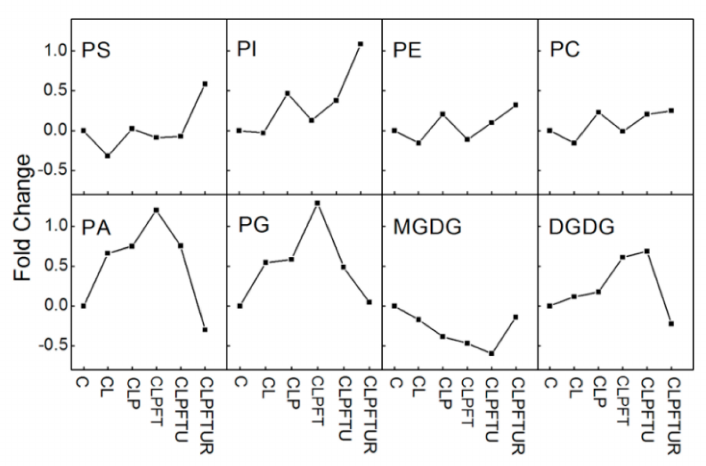
Figure 5. Changes in levels of eight phospholipids in Magnolia officinalis ECs during cryopreservation. The fold changes were calculated using the average amount of total lipids of each class ( n = 5) with the formula (A2 − A1)/A1, where A2 is the total lipid class amount for the indicated process (notation in Figure 1 legend) and A1 is the total lipid amount in the